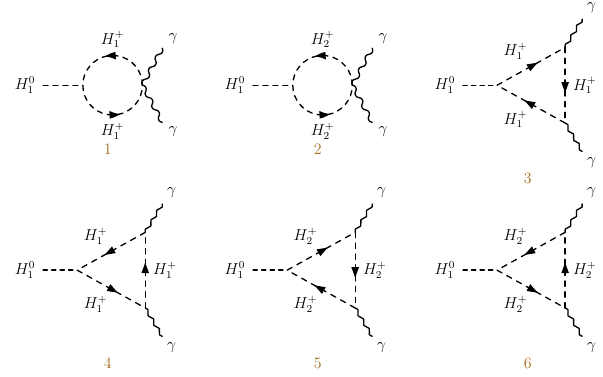
Fig. 4 Charged scalars contributions to h → γγ